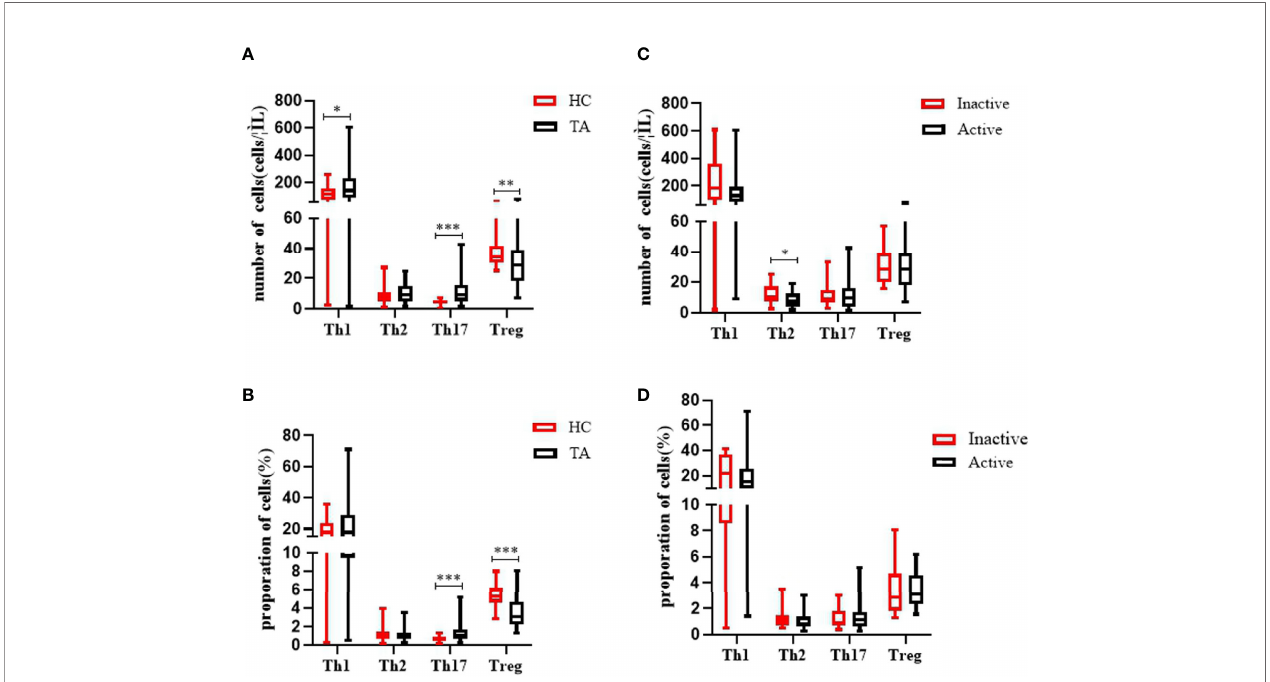
FIGURE 2 | Characteristics of the absolute numbers and proportions of Th17 cells and CD4Treg cells in the PB of patients with TA. (A, B) The levels of Th1 cells and Th17 cells in PB were signi fi cantly increased in patients with TA (n = 57). The absolute number and the proportion of CD4Treg cells were signi fi cantly decreased in TA (n = 57). There were no signi fi cant changes of the absolute numbers and proportion of Th2 in PB between healthy controls (n = 43). (C, D) The absolute number of Th2 cells in PB were signi fi cantly decreased in active patients with TA (n = 36). Neither the absolute number nor proportion of Th1, Th17, and Treg cells were altered signi fi cantly between active TA patients (n = 36) and inactive TA patients (n = 21). Data were presented as mean ± SD. Shown are the signi fi cant differences assessed by the Mann – Whitney U test. *P < 0.05; **P < 0.001, ***P < 0.001. P < 0.05 was considered statistically signi fi cant. TA, Takayasu ’ s arteritis; PB, peripheral blood; Tregs, regulatory T